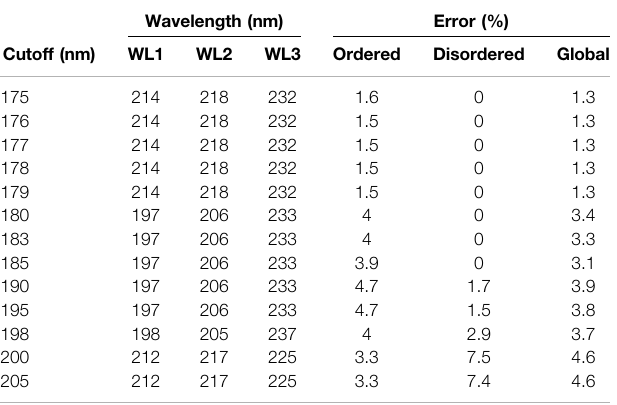
TABLE 2 | Accuracy of KNN-cosine algorithm as a function of cutoff wavelength. a Wavelength (nm) Error (%) Cutoff (nm)